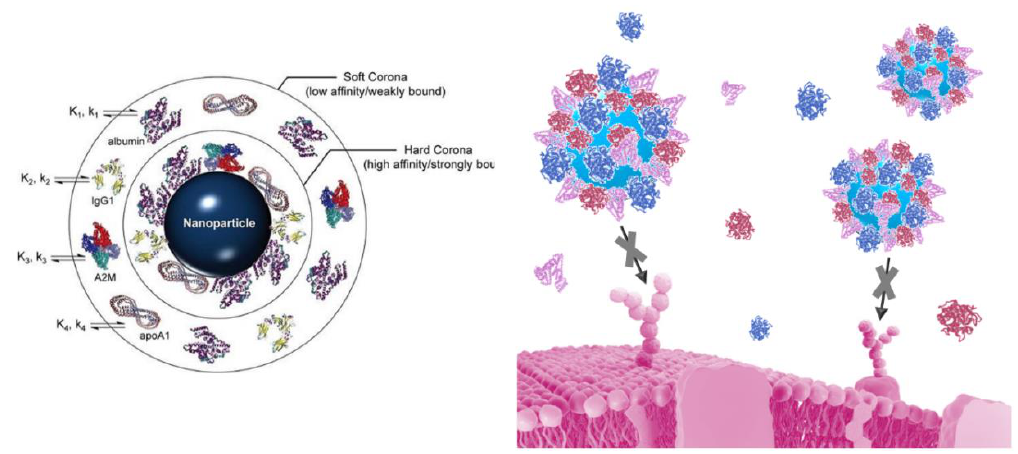
Figure 22. Left : Schematic of soft and hard corona formed on the surface of a NP. Reproduced with permission from Bhattacharjee et al. [229], copyright by Elsevier 2016. Right : schematic representation of loss of transferrin receptor targeting for transferrin-conjugated nanoparticles in the presence of corona proteins. Adapted from Salvati et al. [250], published by Springer Nature, 2013.